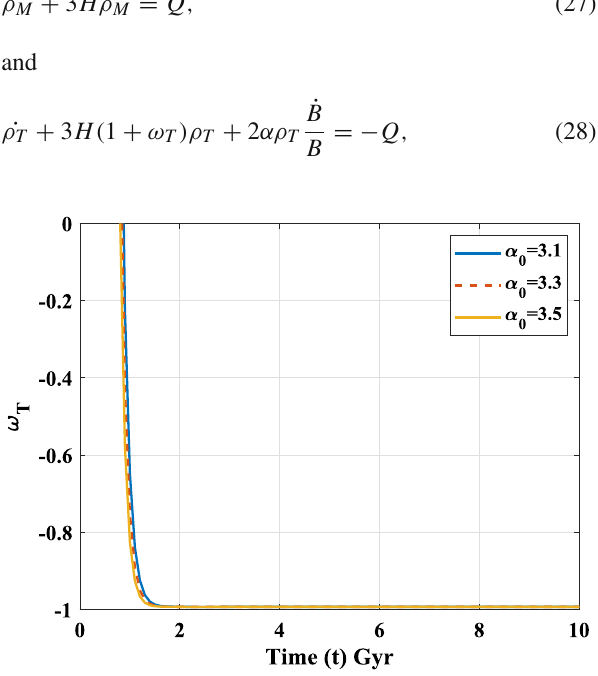
Fig. 4 Plot of EoS parameter ( ω T ) versus time ( t ) for k = 1 . 9, α 1 = 1 . 2, α 2 = 0 . 52, and γ 1 =